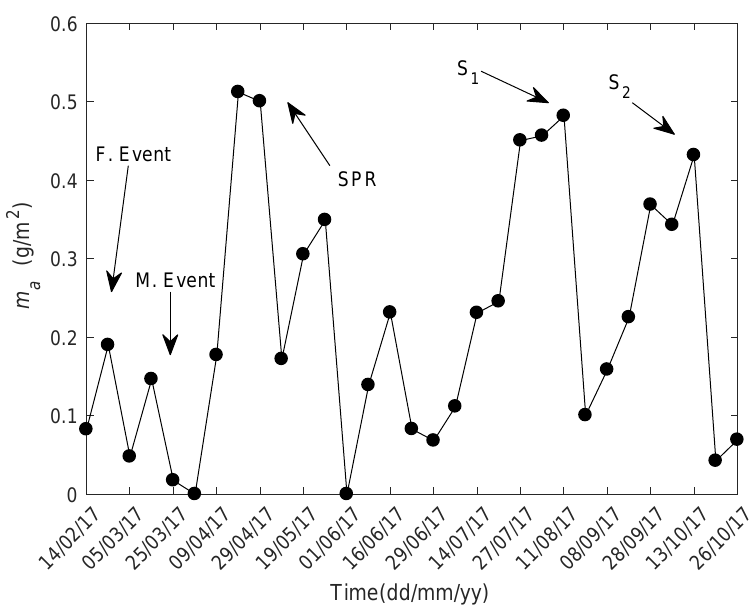
Figure 5. Mass accumulation on 30 o tilted glass